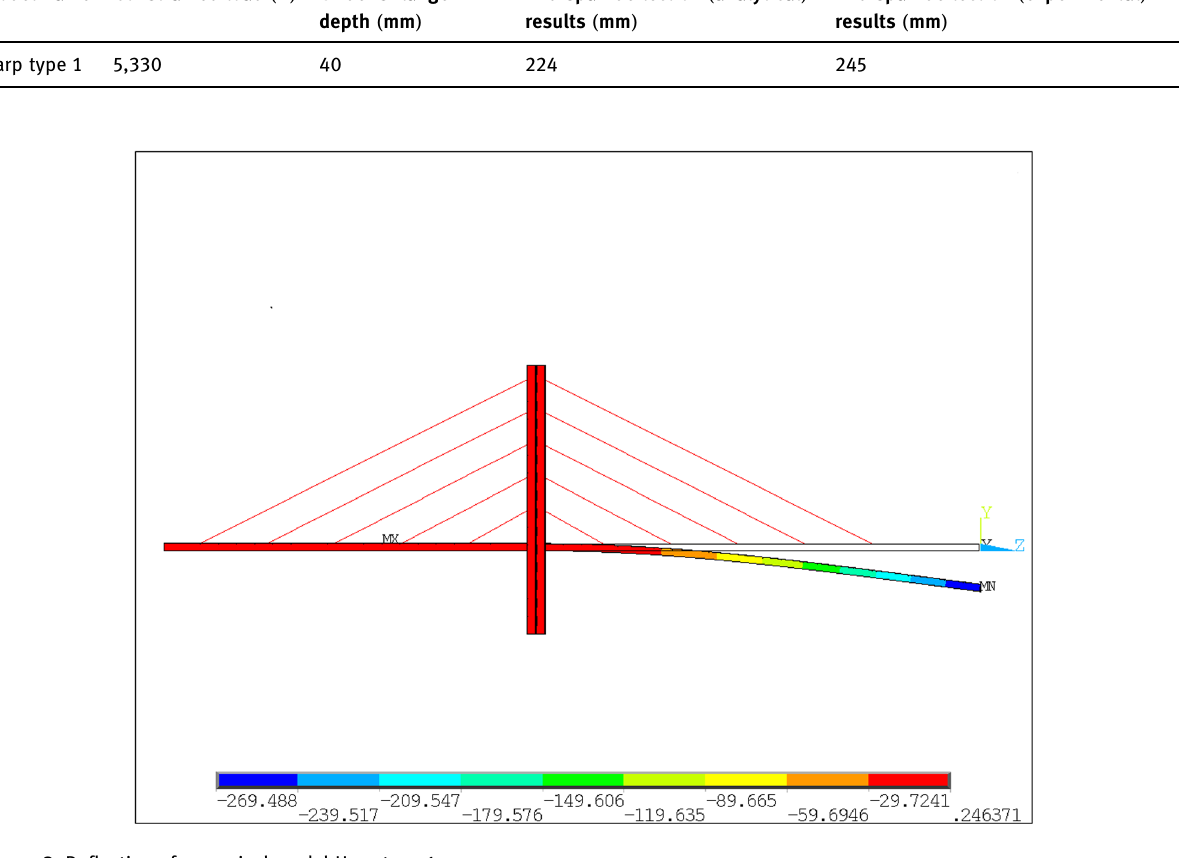
Figure 8: De fl ection of numerical model Harp type 1.